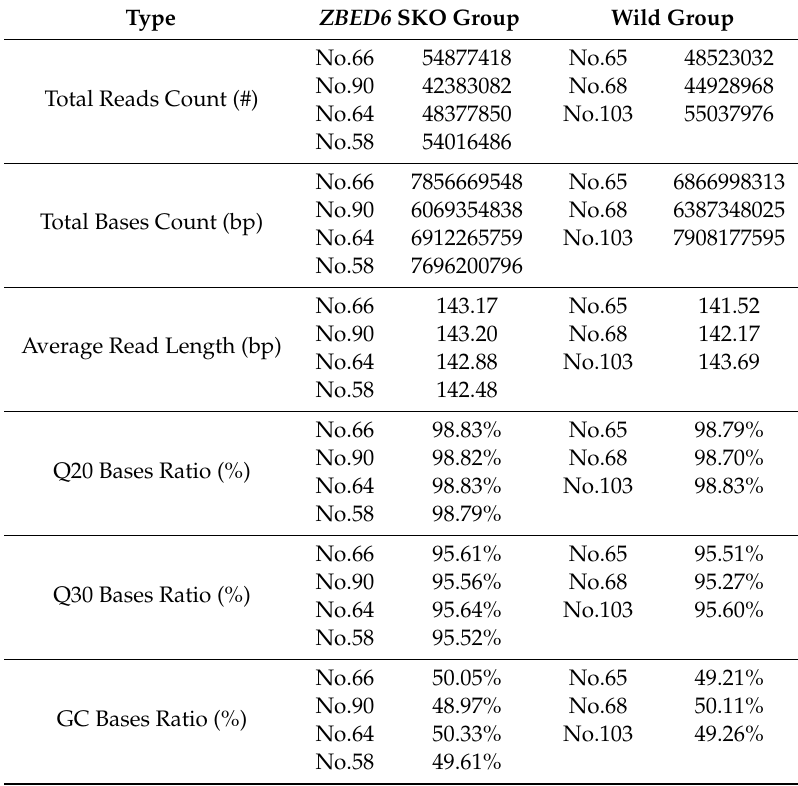
Table 2. Quality evaluation of sequencing